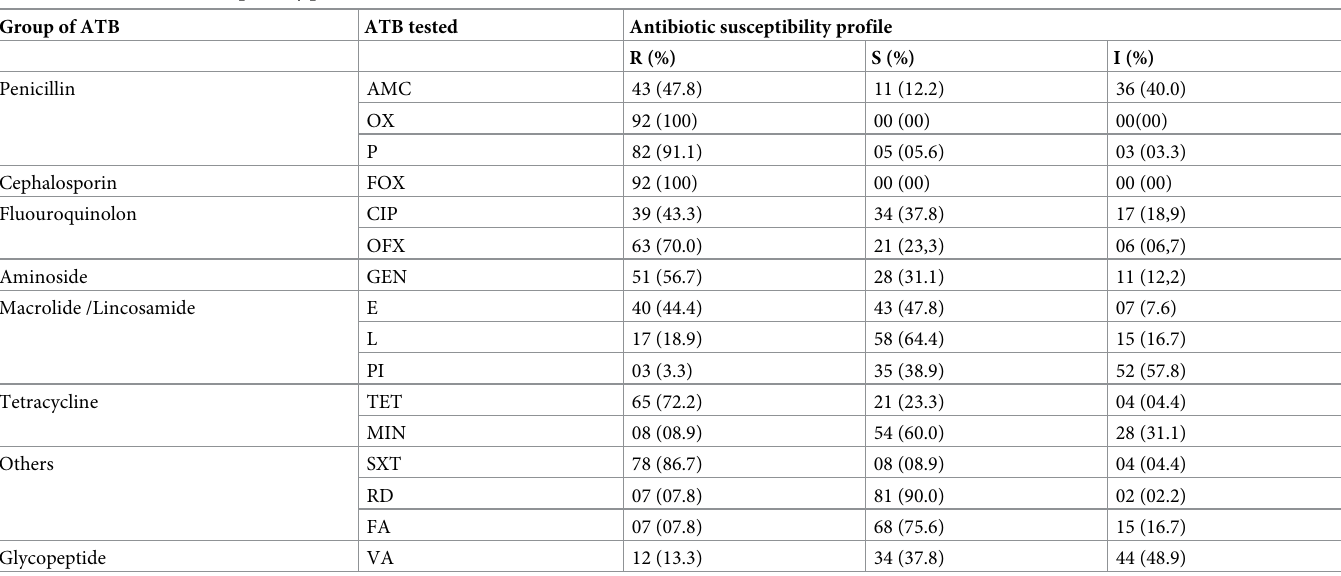
Table 5. Antimicrobial susceptibility profile of MRSA isolates.